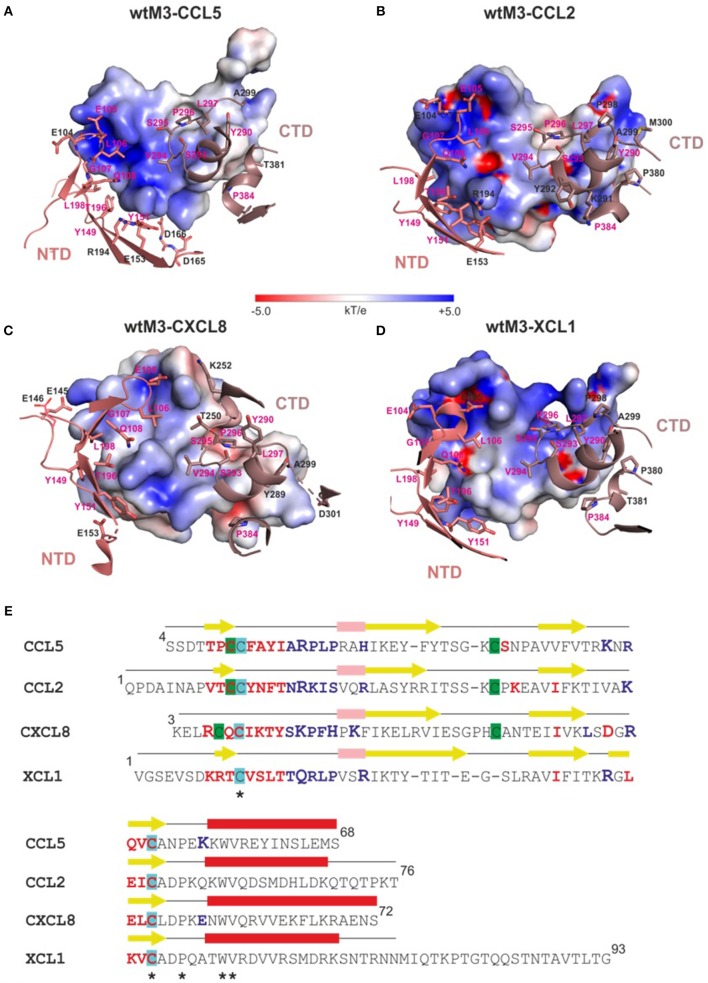
Interfaces of modeled wtM3 complexes with CCL5 and CXCL8 and crystal structures of wtM3 with CCL2 and XCL1. (A–D) show those residues of the NTD (salmon) and CTD (gray) of wtM3 within 4 Å of residues from the CCL5 (A), CCL2 (B), CXCL8 (C), and XCL1 (D) chemokines. Residues which interact with all four chemokines are labeled in magenta. The electrostatic surface of each chemokine is shown (range ±5 kT/e). These surfaces were prepared using APBS (Zhou et al., 2000) and displayed using PyMOL. (E) Structure-based sequence alignment of CCL5, CCL2, CXCL8, and XCL1. The secondary structure elements of each chemokine are indicated above its sequence (α-helices are red, 310 helices are pink and β-sheets are yellow). Residues which are identical (*) in all four structures are indicated. Chemokine residues which interact with the M3 NTD and CTD colored blue and red, respectively. Residues which form salt bridges at the M3-chemokine interface are printed larger. Cysteines forming disulphide bonds are undercoated with the same color.